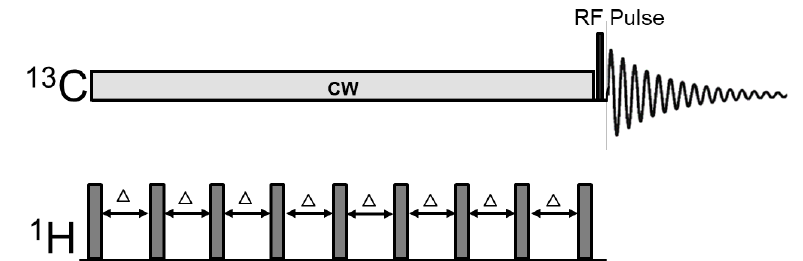
Figure 2. Radiofrequency pulse sequence for the 13 C saturation transfer experiments. 1 H → 13 C heteronuclear Nuclear Overhauser Enhancement (NOE) was generated by saturating proton signals using evenly spaced non-selective hard pulses. A continuous wave (CW) 13 C pulse or a train of spectrally selective shaped 13 C pulses was used for radiofrequency saturation at CO 2 resonance or at the control frequency on the opposite side of bicarbonate. For excitation, a 13 C block pulse was used. ∆ : Delay between proton pulses (48 ms).